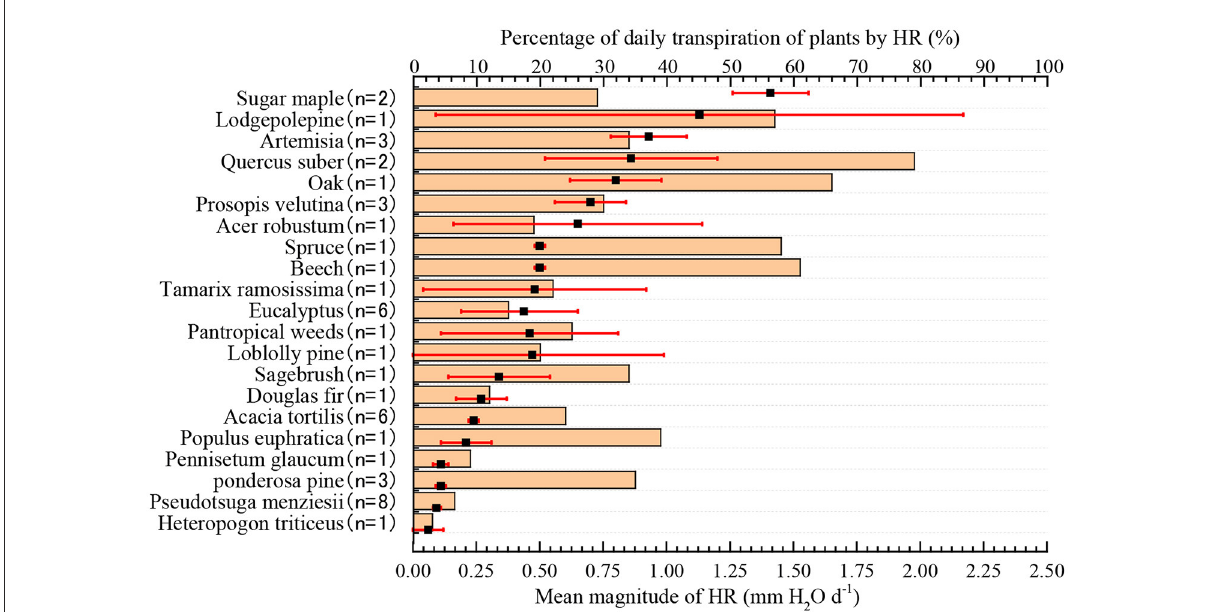
FIGURE2 The amount of HR and its percentage of average daily transpiration. The filled black square represents the mean plant HR, and the red error bar is a 95% CI. The tan bars represent the percentage of HR in the average daily transpiration of plants.